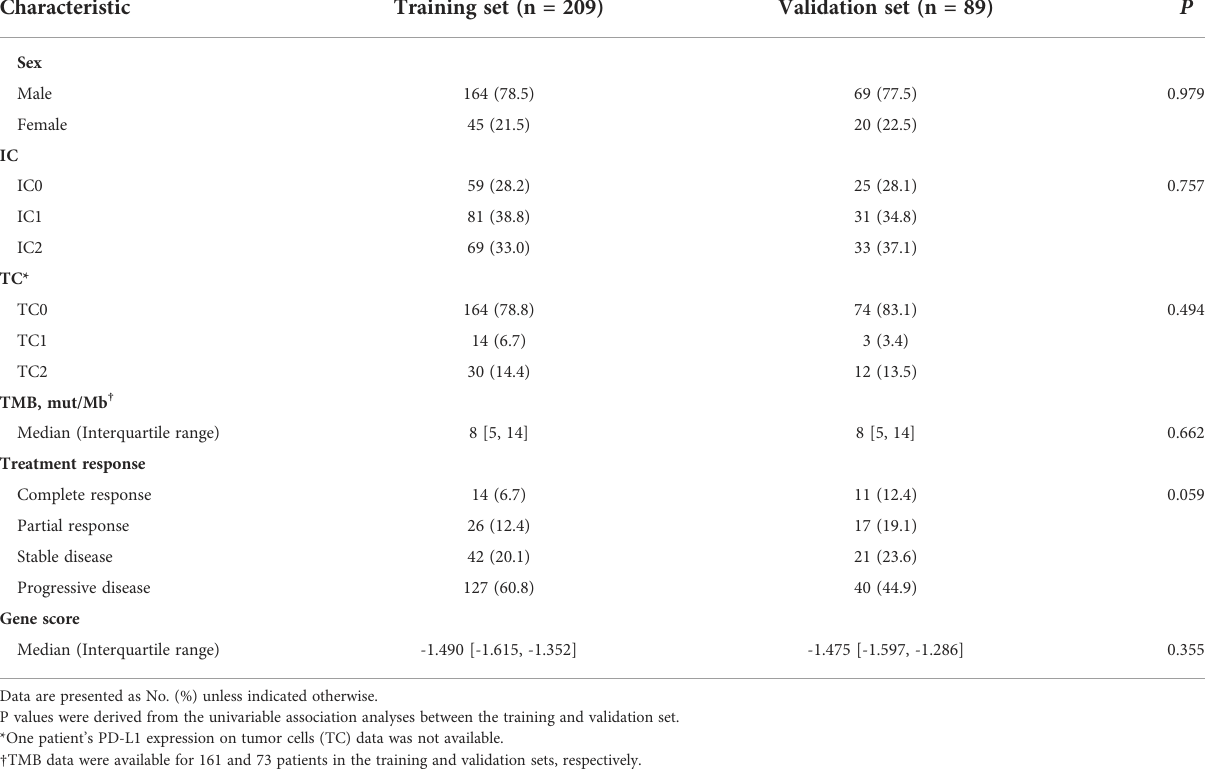
TABLE 1 Baseline characteristics of the